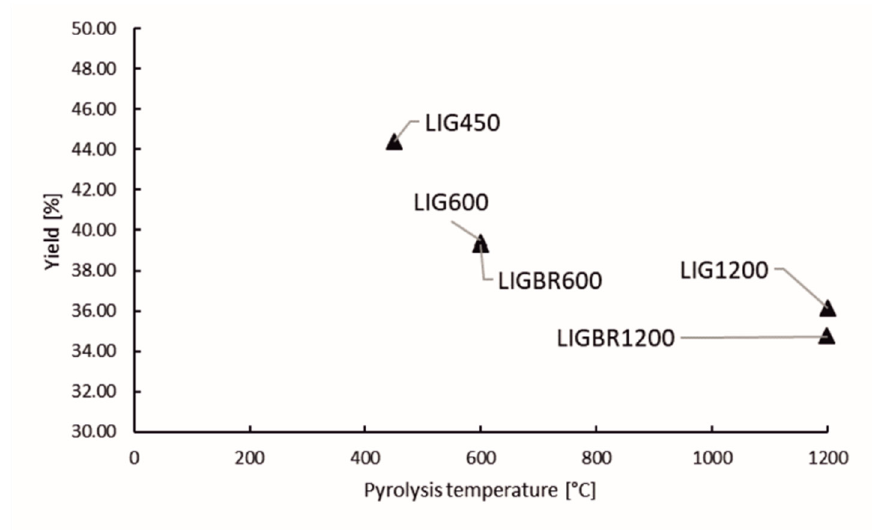
Figure 3. Yield of lignin